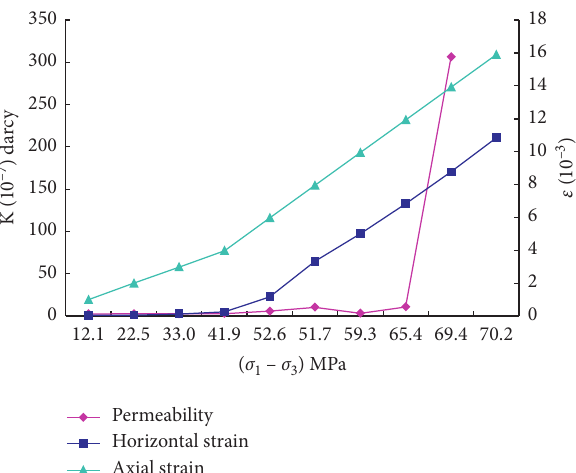
Figure 14: Permeability-horizontal strain-axial strain curves of